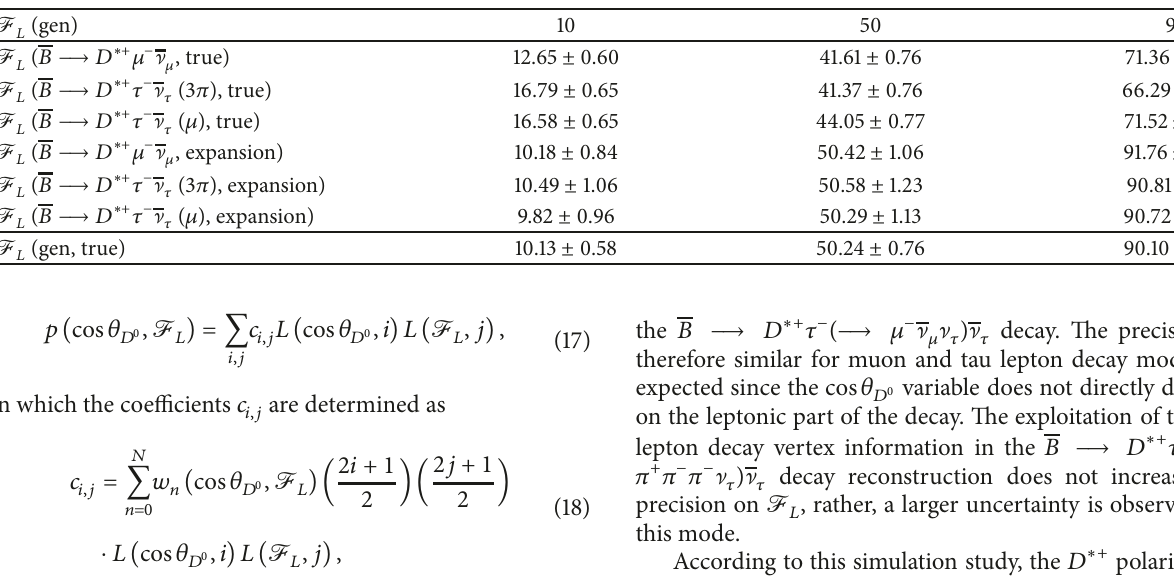
Table 1: Measured 𝐷 ∗+ longitudinal polarization (in %) by fitting the true angular distribution equation (7) or the polynomial expansions equation (17) to the 𝐵 󳨀→ 𝐷 ∗+ 𝑙 − ] 𝑙 test samples for varying generated F 𝐿 values; the last row reports the ideal measurements obtained by fitting the true angular distribution to a toy sample generated from the same distribution with the same number of events of the test